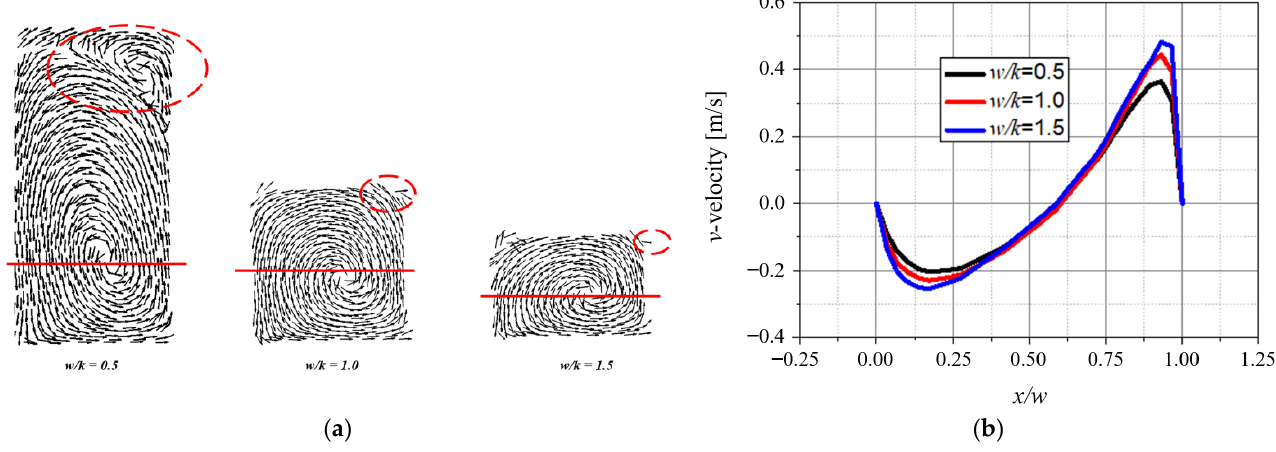
Figure 10. The velocity vector and distribution for corrugated pipe inside the groove : ( a ) The velocity vectors in the groove for the various ratios of w / k and ( b ) its v -velocity distribution.